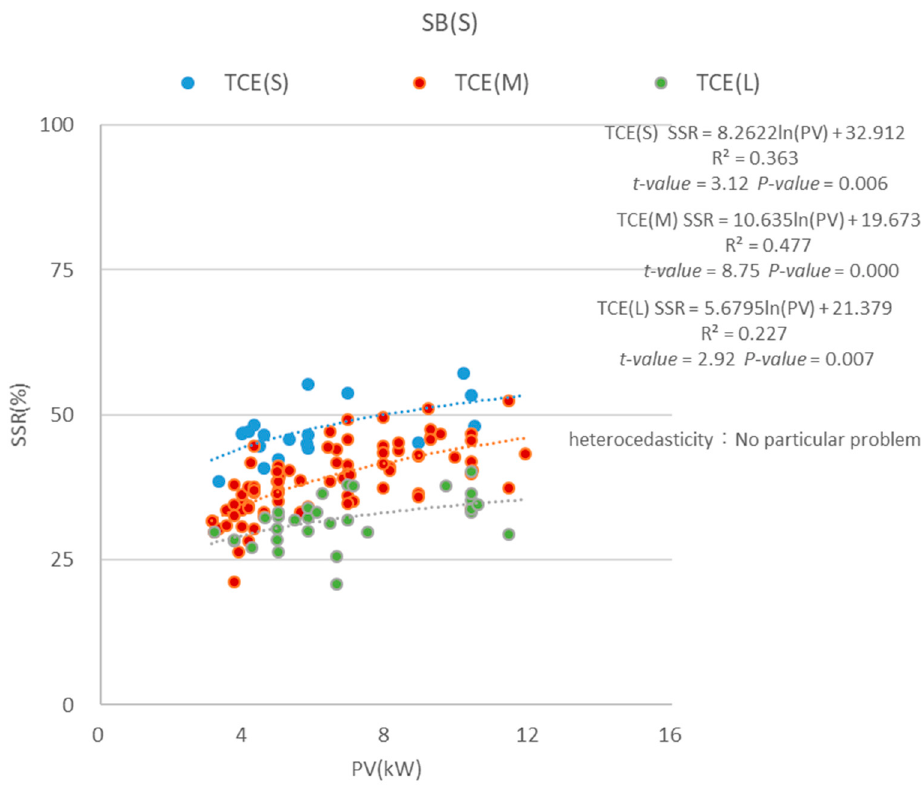
Figure 20. Self-sufficiency rate ( SSR ) regression equation for each PV capacity by SB (S) green mode (GRM) and HPWH 100%.